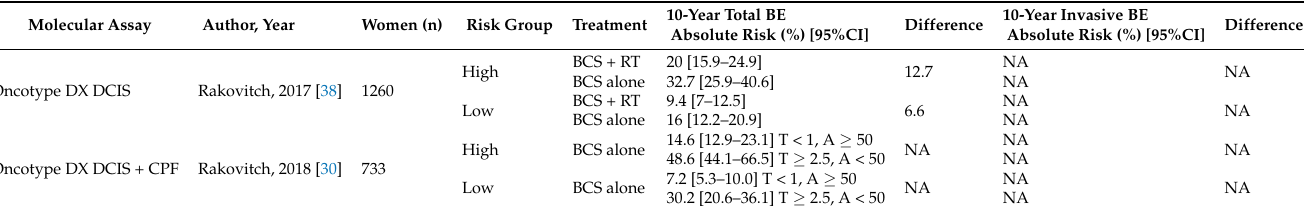
Table 3. Oncotype Dx DCIS 10-year absolute risk of local recurrence stratified by treatment, risk group and recurrence